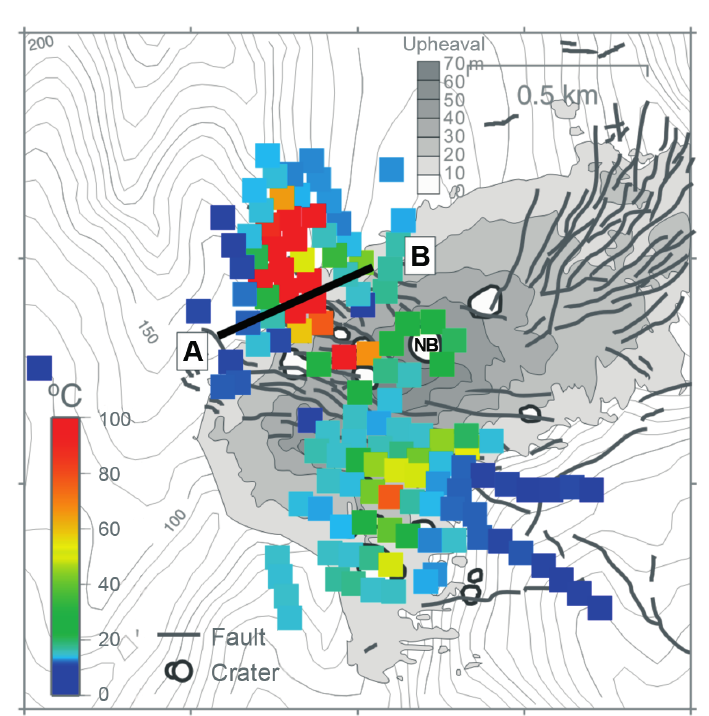
Fig. 3. Distribution of the ground temperature in 1m depth measured in October-November, 2000. A-B denotes the measurement